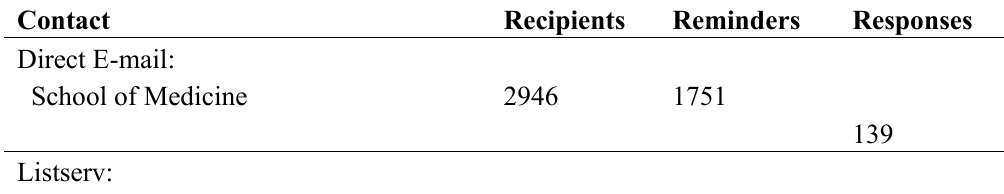
Table 1. Advertising strategy for survey participant recruitment. Contact